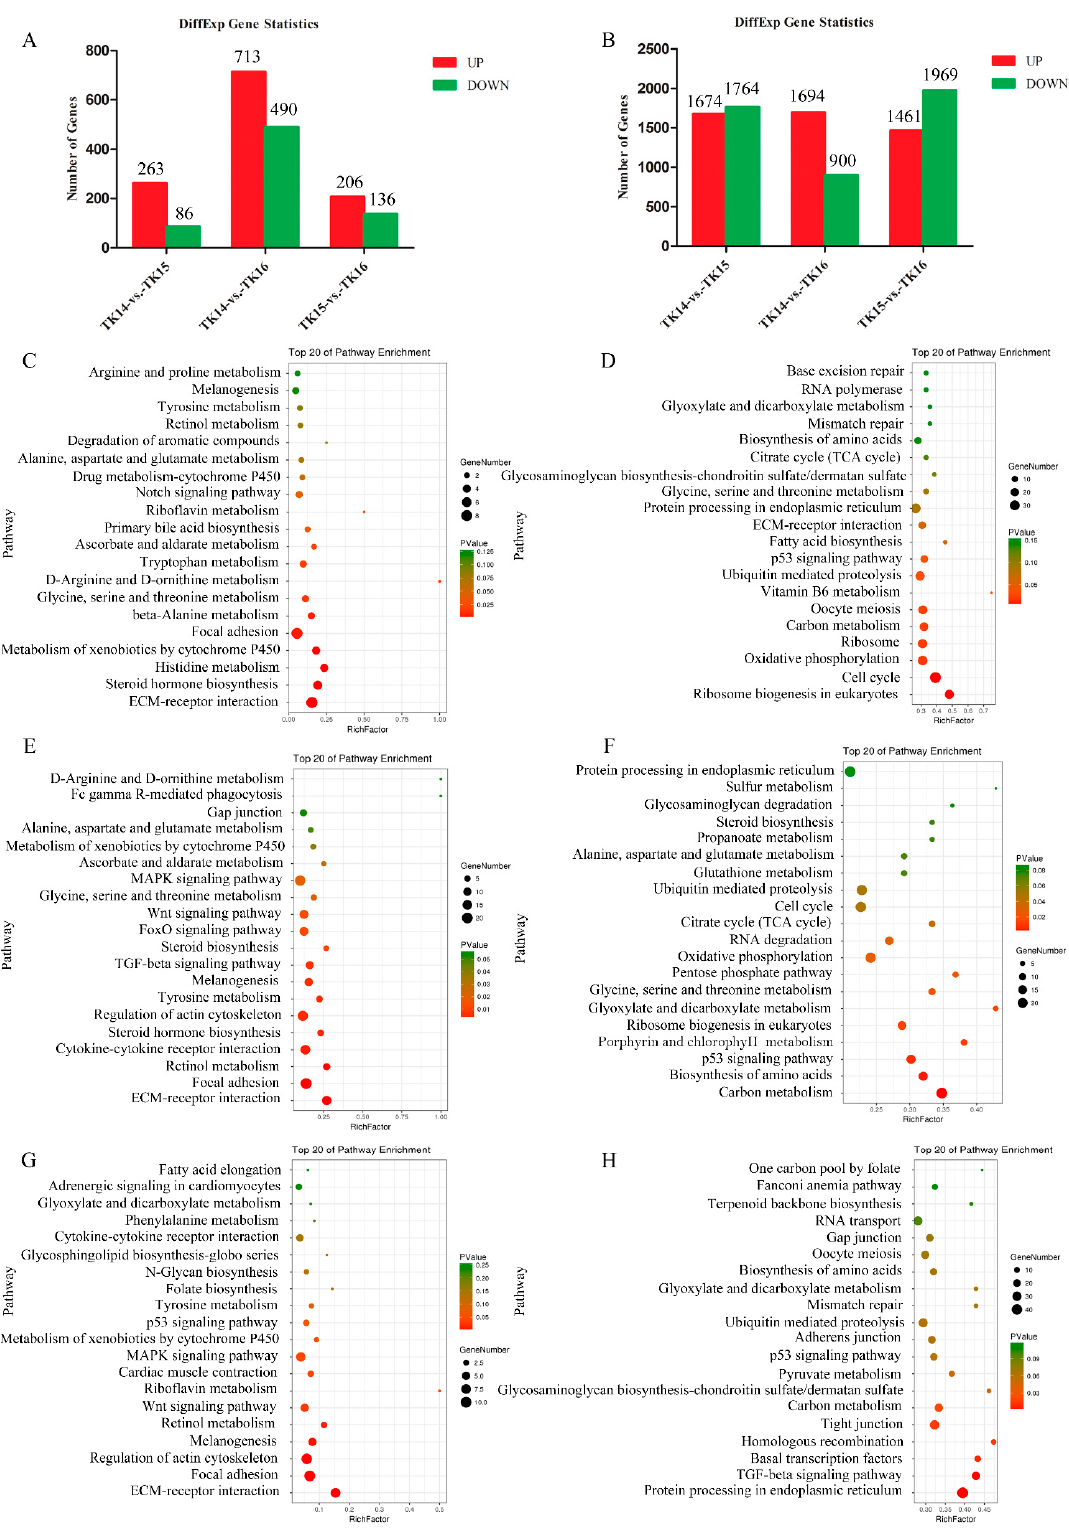
Figure 1. ( A ) DTRGs-TK14 vs. TK15, DTRGs-TK14 vs. TK16, and DTRGs-TK15 vs. TK16. ( B ) DTLGs-TK14 vs. TK15, DTLGs-TK14 vs. TK16, and DTLGs-TK15 vs. TK16. ( C ) Top 20 enriched KEGG pathways of DTRGs-TK14 vs. TK15. ( E ) Top 20 enriched KEGG pathways of DTRGs- TK14 vs. TK16. ( G ) Top 20 enriched KEGG pathways of DTRGs-TK15 vs. TK16. ( D ) Top 20 enriched KEGG pathways of DTLGs-TK14 vs. TK15. ( F ) Top 20 enriched KEGG pathways of DTLGs-TK14 vs. TK16. ( H ) Top 20 enriched KEGG pathways of DTRGs-TK15 vs.